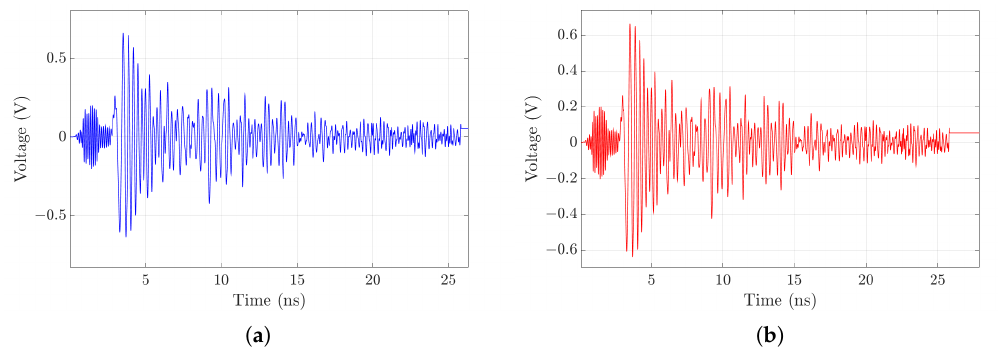
Figure 17. Comparison between the differences of the reflected voltage generated by the far anti- dipole Vivaldi antenna from the epoxy-resin blade: ( a ) the distinctions between an intact and a cracked simple large blade; ( b ) the distinctions between an intact simple large blade and a two-cracked blade.